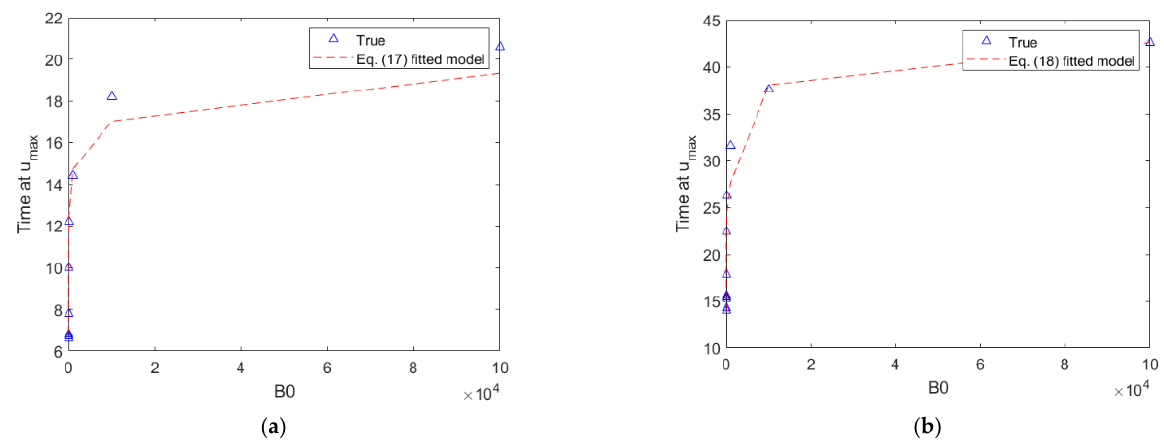
Figure 9. The t max time of Policy 2 against the changes in B 0 of Equation (15), versus the fitted models of Equations (17) and Figure 9. The max t time of Policy 2 against the changes in 0 B of Equation (15), versus the fitted models of Equations (17) (18). ( a ) Control effort u 1 ; ( b ) Control effort u 2 . and (18). ( a ) Control effort 1 u ; ( b ) Control effort 2 u .